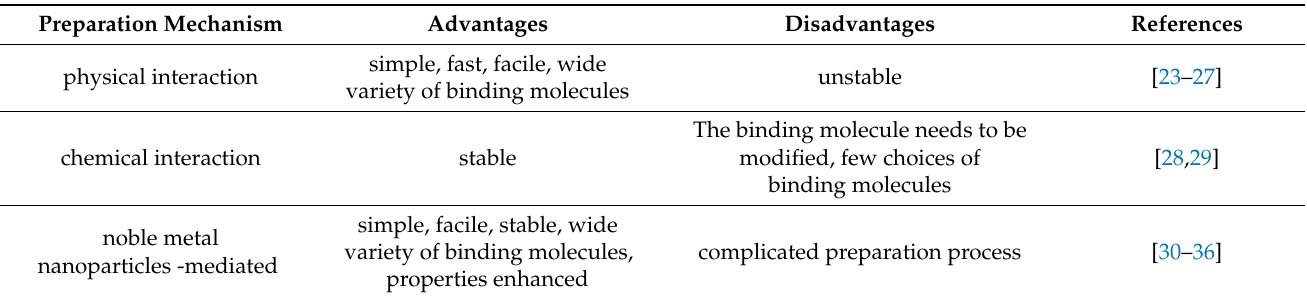
Table 1. Preparation of MoS 2 -based